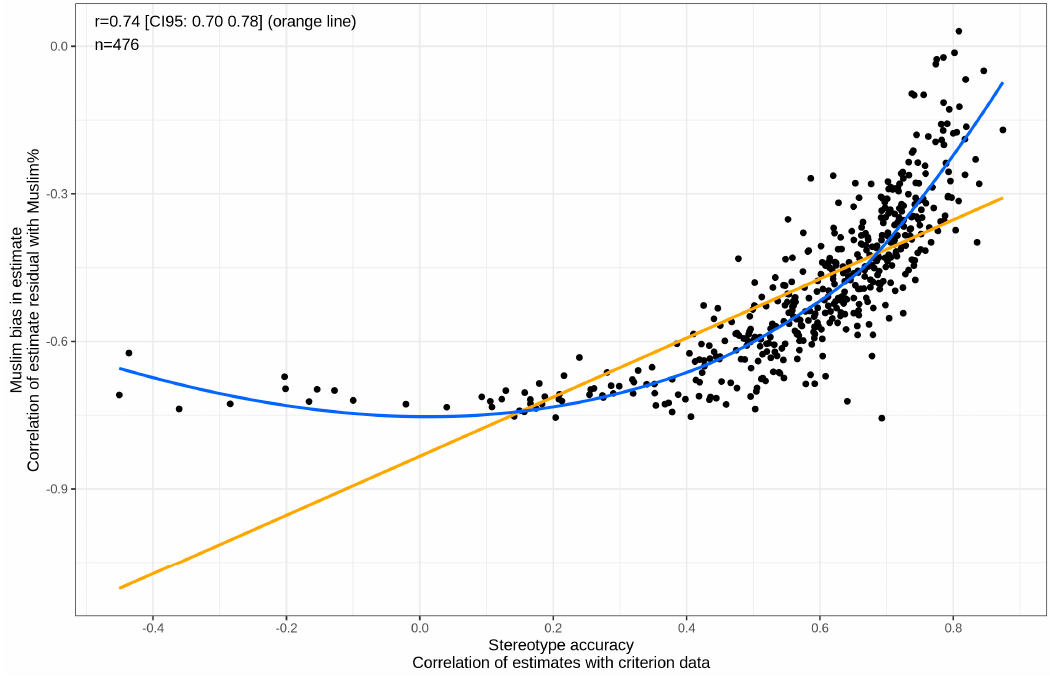
Figure 7. Scatterplot of stereotype accuracy (Pearson r) and Muslim bias (positive means anti-Muslim; negative means pro-Muslim). Orange line = linear fit. Blue line = local regression